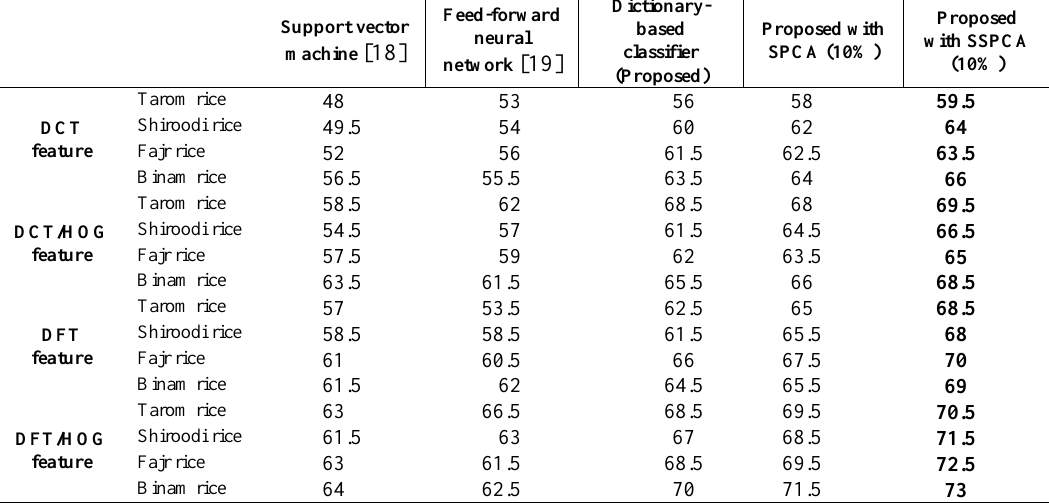
Table 5. Results of the classification rate for rice images based on the DFT and DCT coefficients as well as these coefficients in combination with the PCA algorithm for the neural network classifications, support vector machine, and proposed dictionary-based classifier with the SPCA and SSPCA